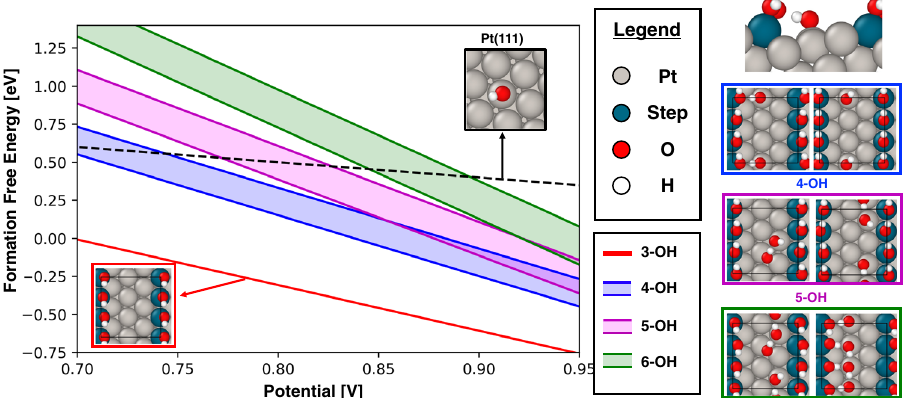
Fig. 5 | Ab initio Pourbaix diagram based on binding energies of various OH* con fi gurationsonPt(111) and Pt(221) surfaces. Inthe potentialregion of interest for ORR, 0.8 – 0.9V, competition between ensembles having 4, 5, and 6 OH* adsorbates per unit cell on Pt(221) (1/4 to 1/2ML OH* coverage) is predicted and is shownby the overlapping free energy bands. On the rightmost sideof the fi gure, a side view of the most stable 4 OH* con fi guration in our analysis is shown (the corresponding top view is inthe 4 OHinset on the leftside). It is observed thatthe OH* present on the terrace site immediately below the Pt step edge (termed “ back